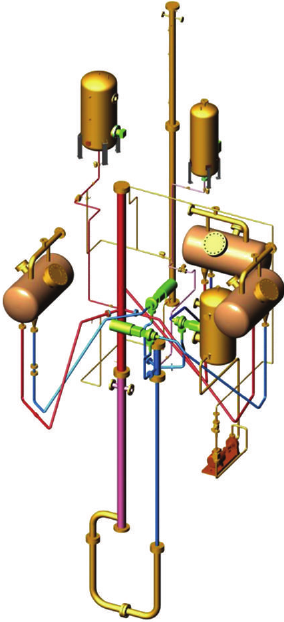
Figure 2: Schematic view of